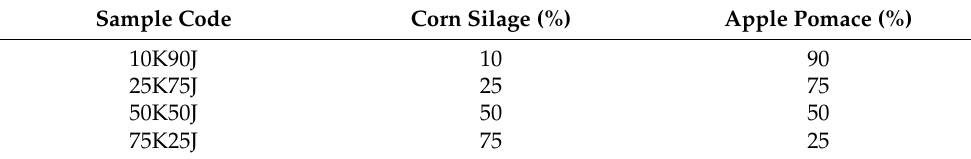
Table 1. Feedstock composition of digestate used as test fuel (% in a received state).